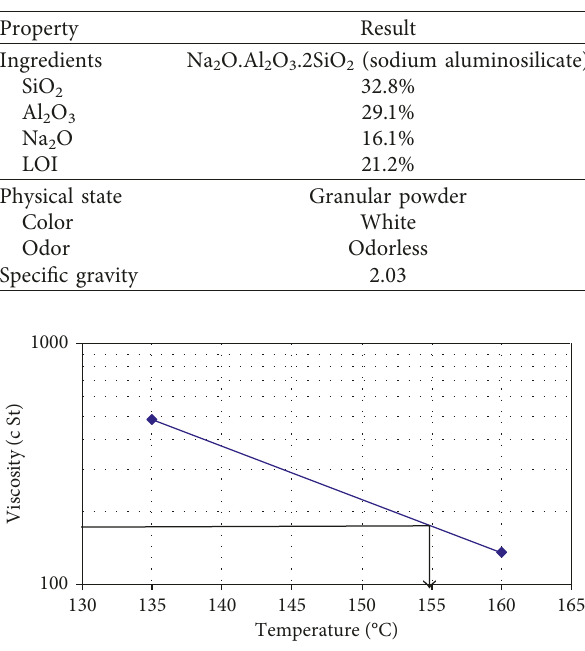
Table 4: Physical and chemical properties of WMA additive, Aspha-min.